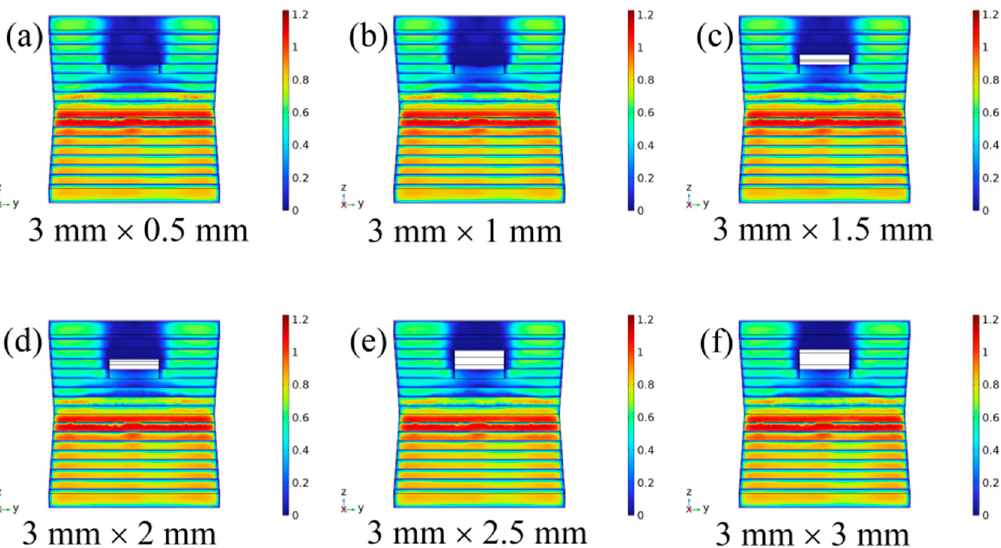
Figure 8. Velocity variations in the bifurcated fracture B for a constant cross-section of 3 mm (velocity: m/s).